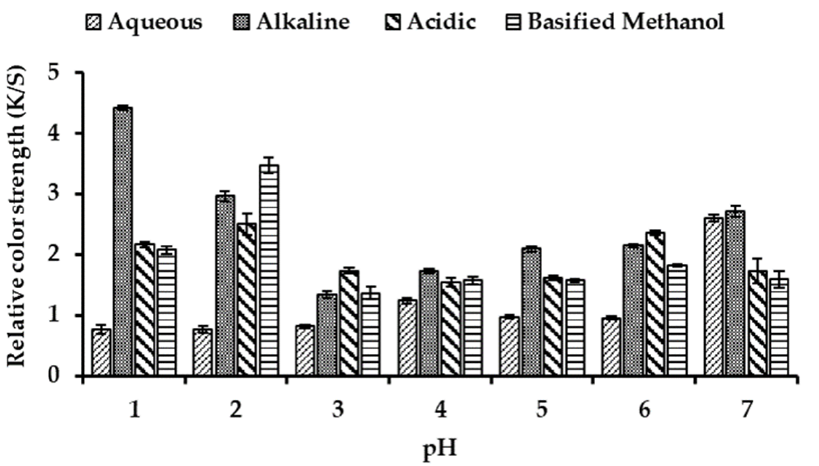
Figure 4. Dyeing of wool with rose extract at various pH values.